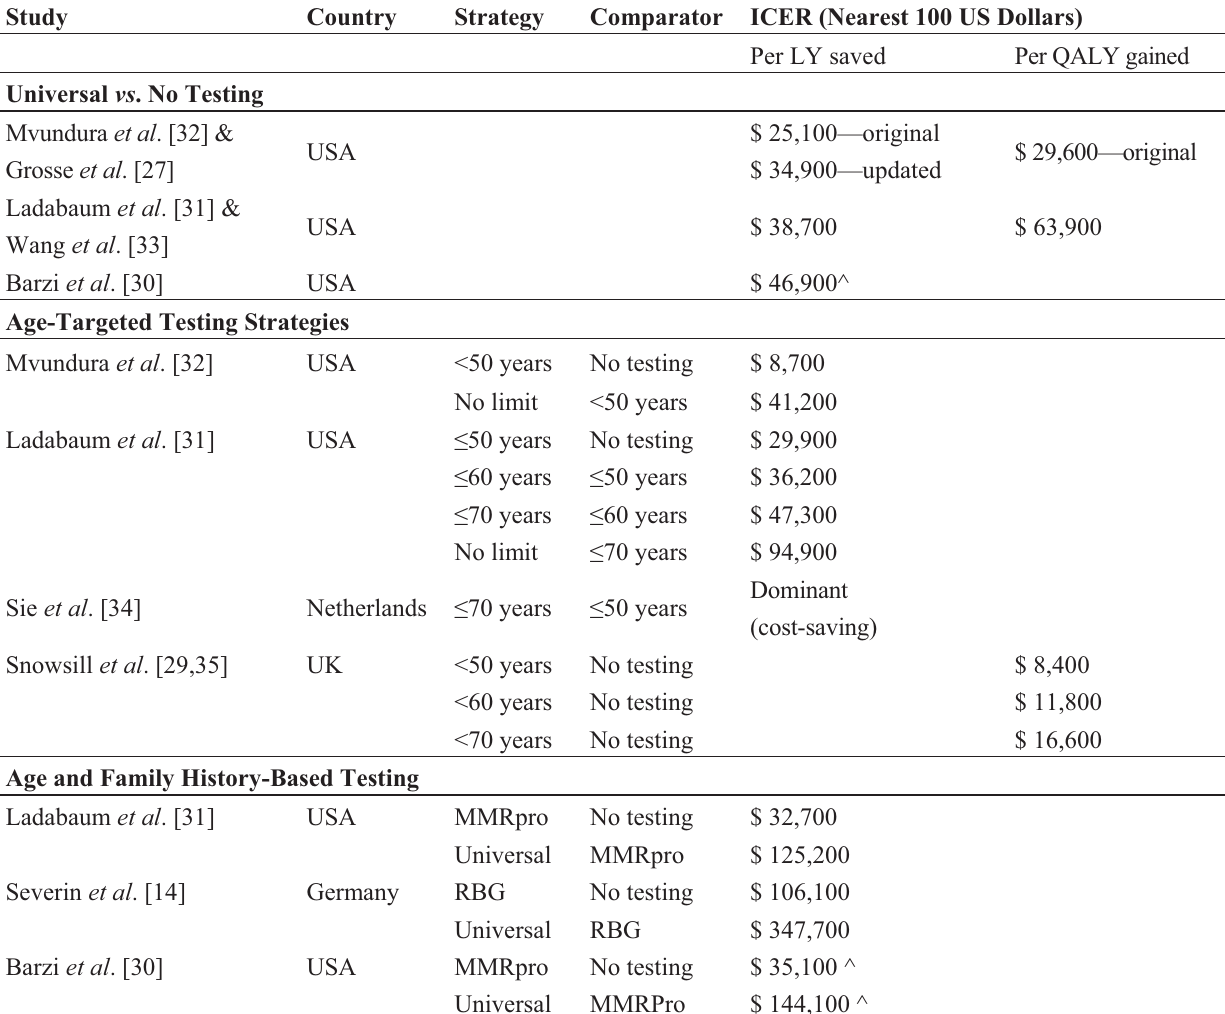
Table 2. Base case incremental cost-effectiveness ratios of testing strategies for Lynch Syndrome in patients with colorectal cancer, adjusted to 2014 US